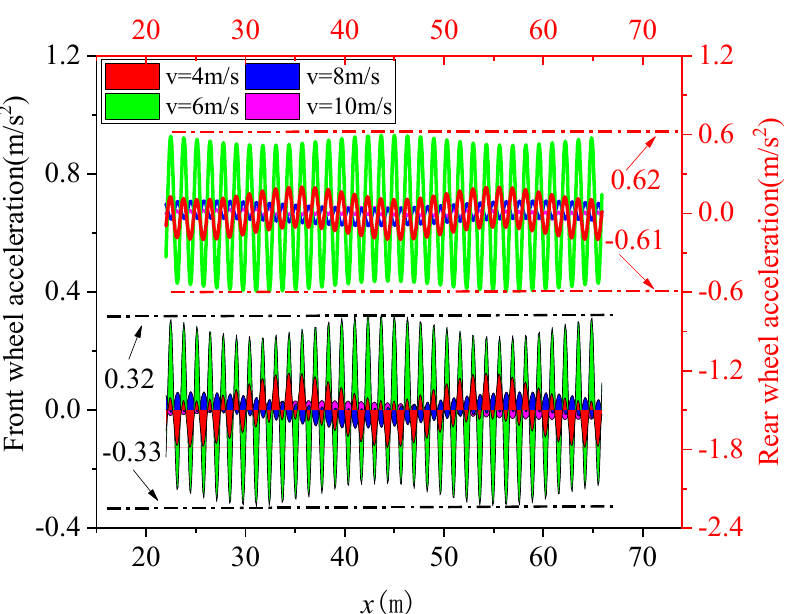
Figure 11. Net vertical acceleration of front and rear wheels at different speeds ( b + c ) ≤ x ≤ 2 ns ( n ∈ N* ).